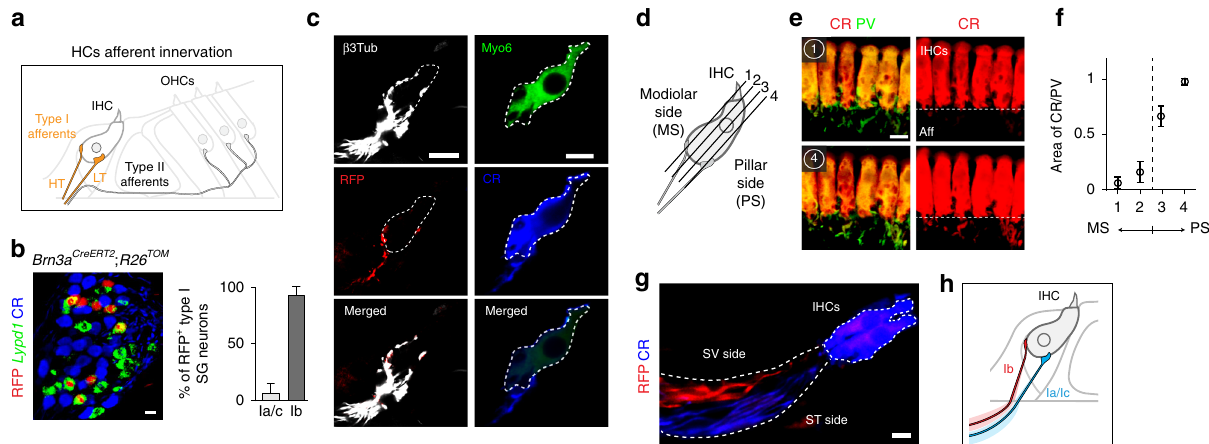
Fig. 5 Innervation pattern of IHCs by type I neurons. a Sketch representing the afferent innervation of the mature organ of Corti, and illustrating the spatial segregation of the peripheral projections and synaptic contacts of high threshold (HT) and low threshold (LT) SG neuron fi bers with IHCs. HT fi bers innervate the modiolar side while LT fi bers, the opposite, pillar side of IHCs. b Genetic labeling of Ib neurons using Brn3a CreERT2 ; R26 TOM , injected with tamoxifen at P21 and analyzed on cross-section at P30. About 96% of RFP + cells were Lypd1 + and were CR − , con fi rming their Ib identity ( n = 3 animals). c In Brn3a CreERT2 ; R26 TOM mice, RFP + Ib fi bers innervate the modiolar side, while CR + Ia and Ic fi bers, the pillar side of IHCs. In the merged panel for the CR (Ia/Ic fi bers) and Myo6 (IHC) staining, the IHC is shadowed to better visualize the innervation. d Schematic of the position of sections shown in e and f . e Whole mount staining of P21 cochlea, using CR and PV immunostaining in WT mice. The images show the presence of CR + fi bers on the pillar side (PS, section #1) and their absence on the modiolar side (MS, section #4) of IHCs, while PV + afferents are observed on either side (Aff: afferents). f Quanti fi cation of the distribution of CR + afferent fi bers at different section levels of the IHCs (from the modiolar side to the pillar side) by measuring the area of the CR + fi bers within the area of PV + fi bers at different levels of the IHC innervation, as shown in d and e ( n = 4 animals). Note that no CR + fi bers were observed outside the PV + fi bers area. g In Brn3a CreERT2 ; R26 TOM mice (see b ), the peripheral projections of Ib (RFP + ) and of Ia/Ic (CR + )